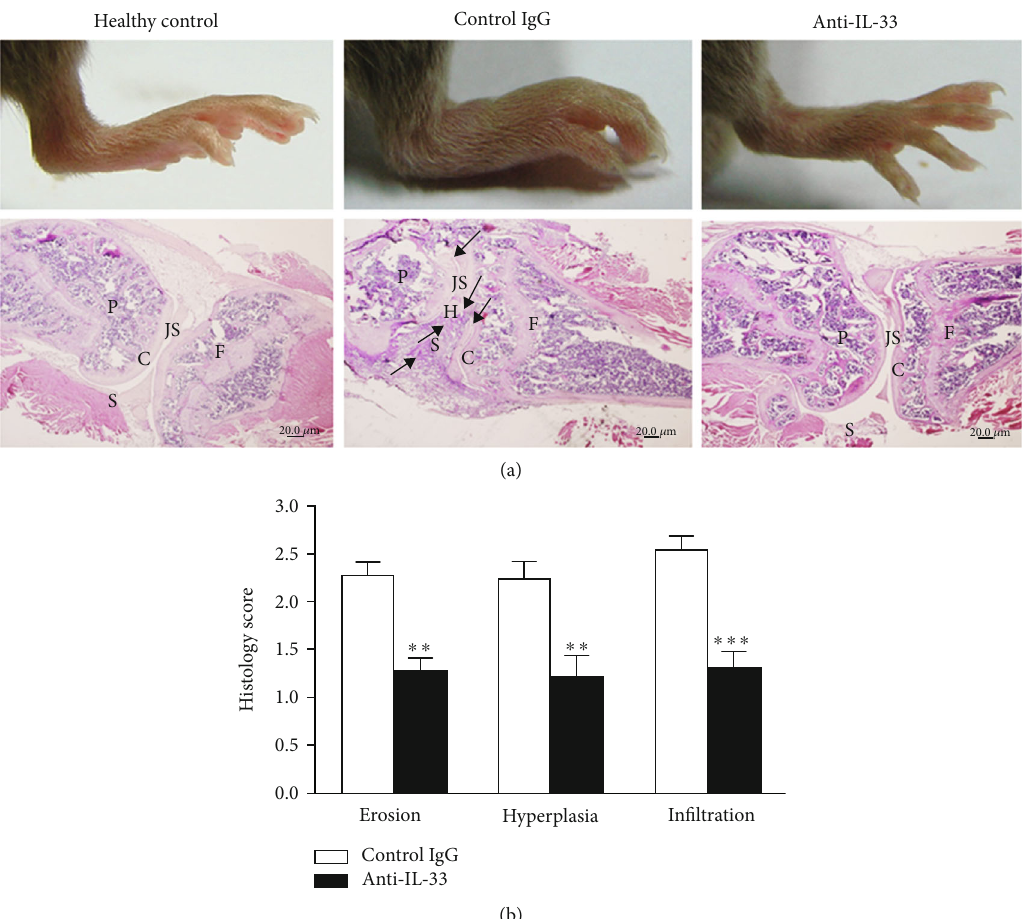
Figure 3: Anti-IL-33 treatment of mice with CIA resulted in reduced joint pathology. (a) On day 43, mice were killed and knee joints were collected and stained with HE. The in fl ammatory in fi ltrate, cartilage destruction, and bone erosion were observed in the control IgG-treated mice (arrows). P: patella; S: synovium; H: hyperplasia; JS: joint space; C: cartilage; F: femur. Magni fi cation: × 40. (b) Anti-IL-33 antibody treatment alleviated the joint damage. The histological features of synovial bone erosion, hyperplasia, and cell in fi ltration were evaluated. Data are mean ± SEM ( n = 8 ); ∗∗ p < 0 : 01 , ∗∗∗ p < 0 : 001 vs. the control IgG group by two-way ANOVA with Bonferroni ’ s multiple comparison